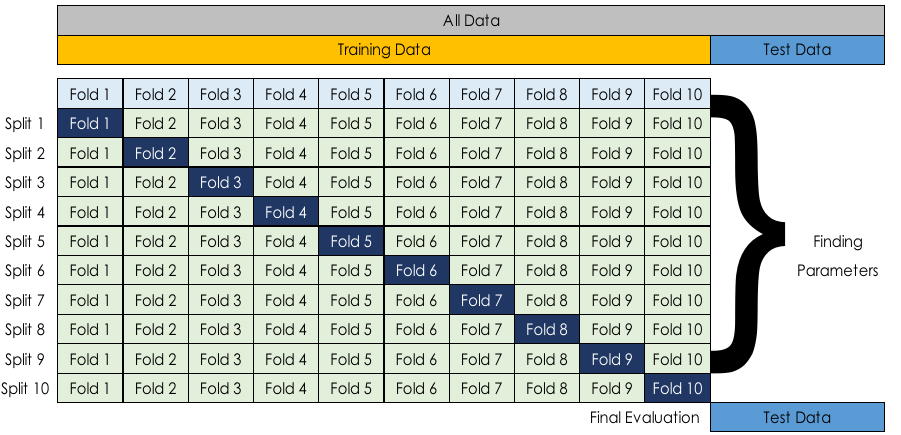
Figure 6. K-fold cross validation